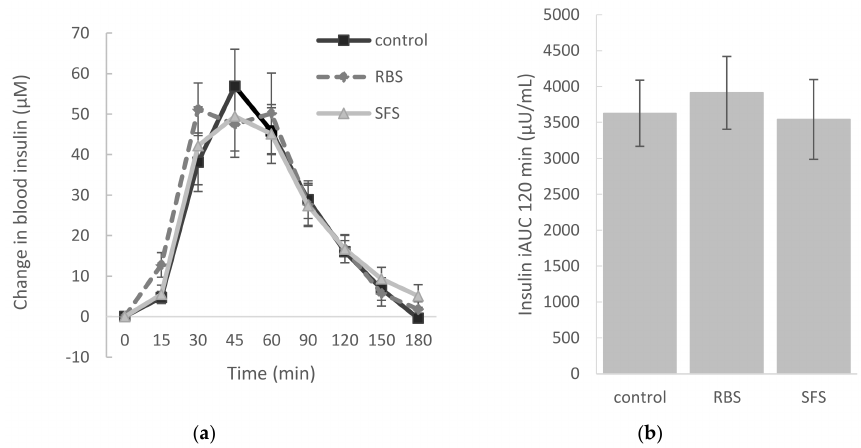
Figure 2. Change in insulin over 180 min ( a ) and incremental area under the curve (iAUC) over 120 min ( b ) for the reference and test foods. * ( p < 0.05) different from the control. RBS: rice bran soymilk, SFS: sugar-free